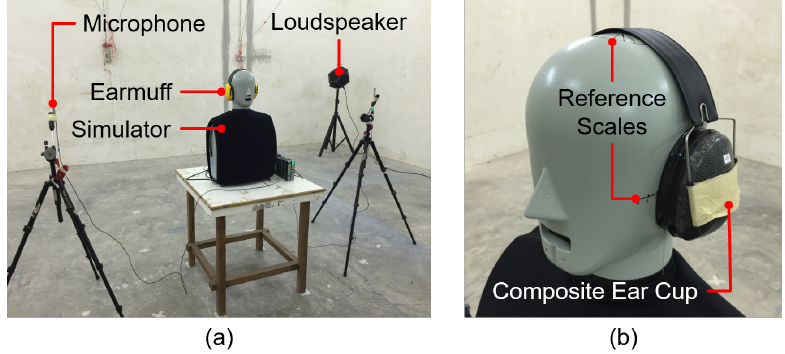
Figure 3. ( a ) Overview of the experimental set-up in the reverberation chamber with a reference earmuff worn on the simulator; and ( b ) closed-up view of the simulator with the composite earmuff worn based on the reference